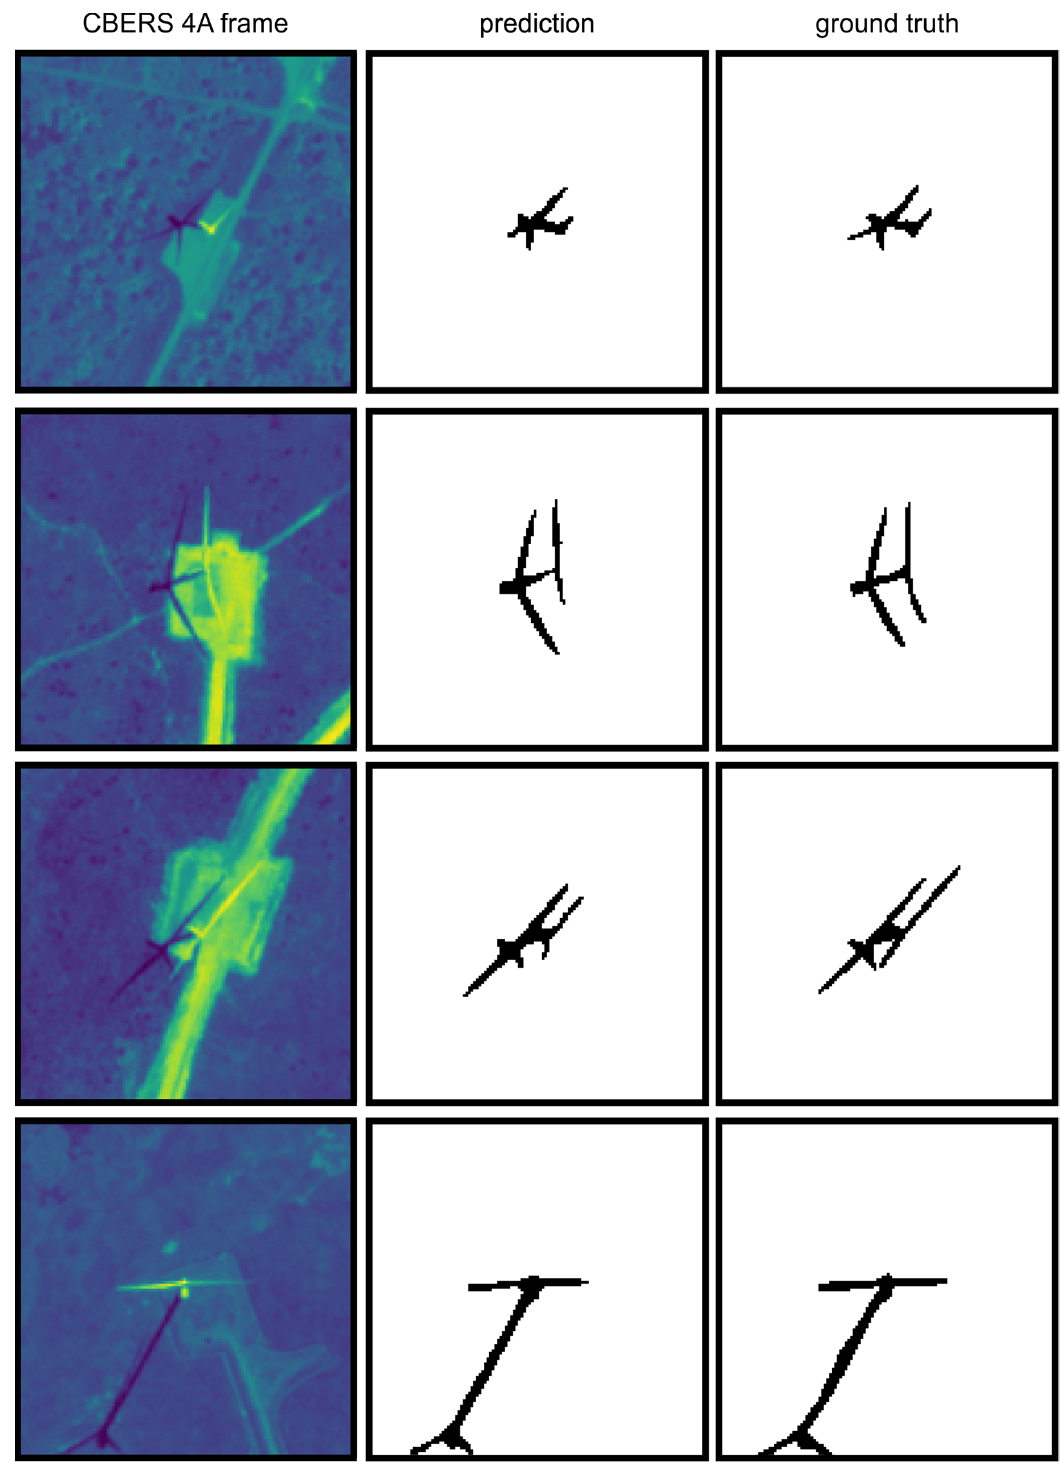
Figure 4. Image patches from the test set considering the original CBERS 4A image, ground truth, and deep learning prediction.